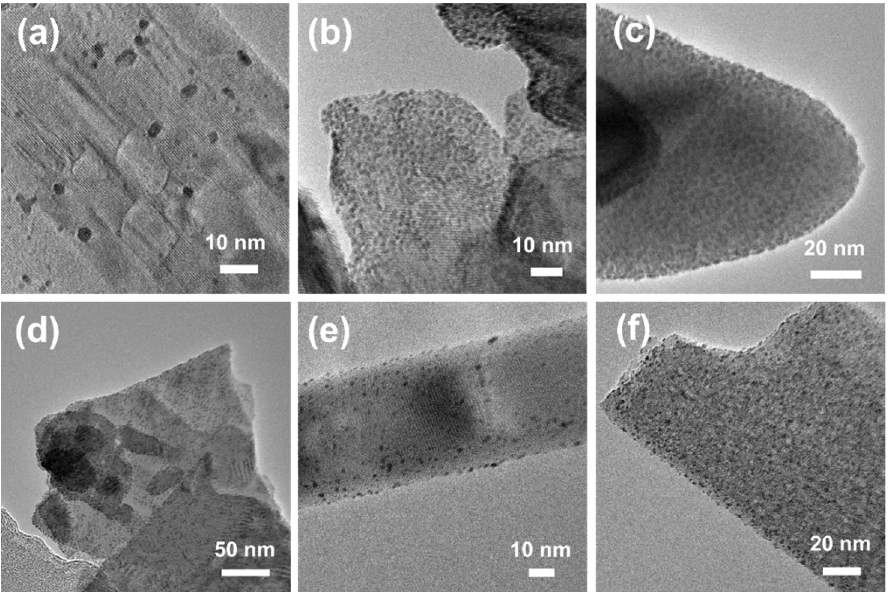
Figure 3. TEM images of Pt-deposited TiO 2 MP ( a ), Bi 2 WO 6 ( b ), BiVO 4 ( c ), CuS ( d ), TiO 2 t1 ( e ), and TiO 2 t2 ( f ).